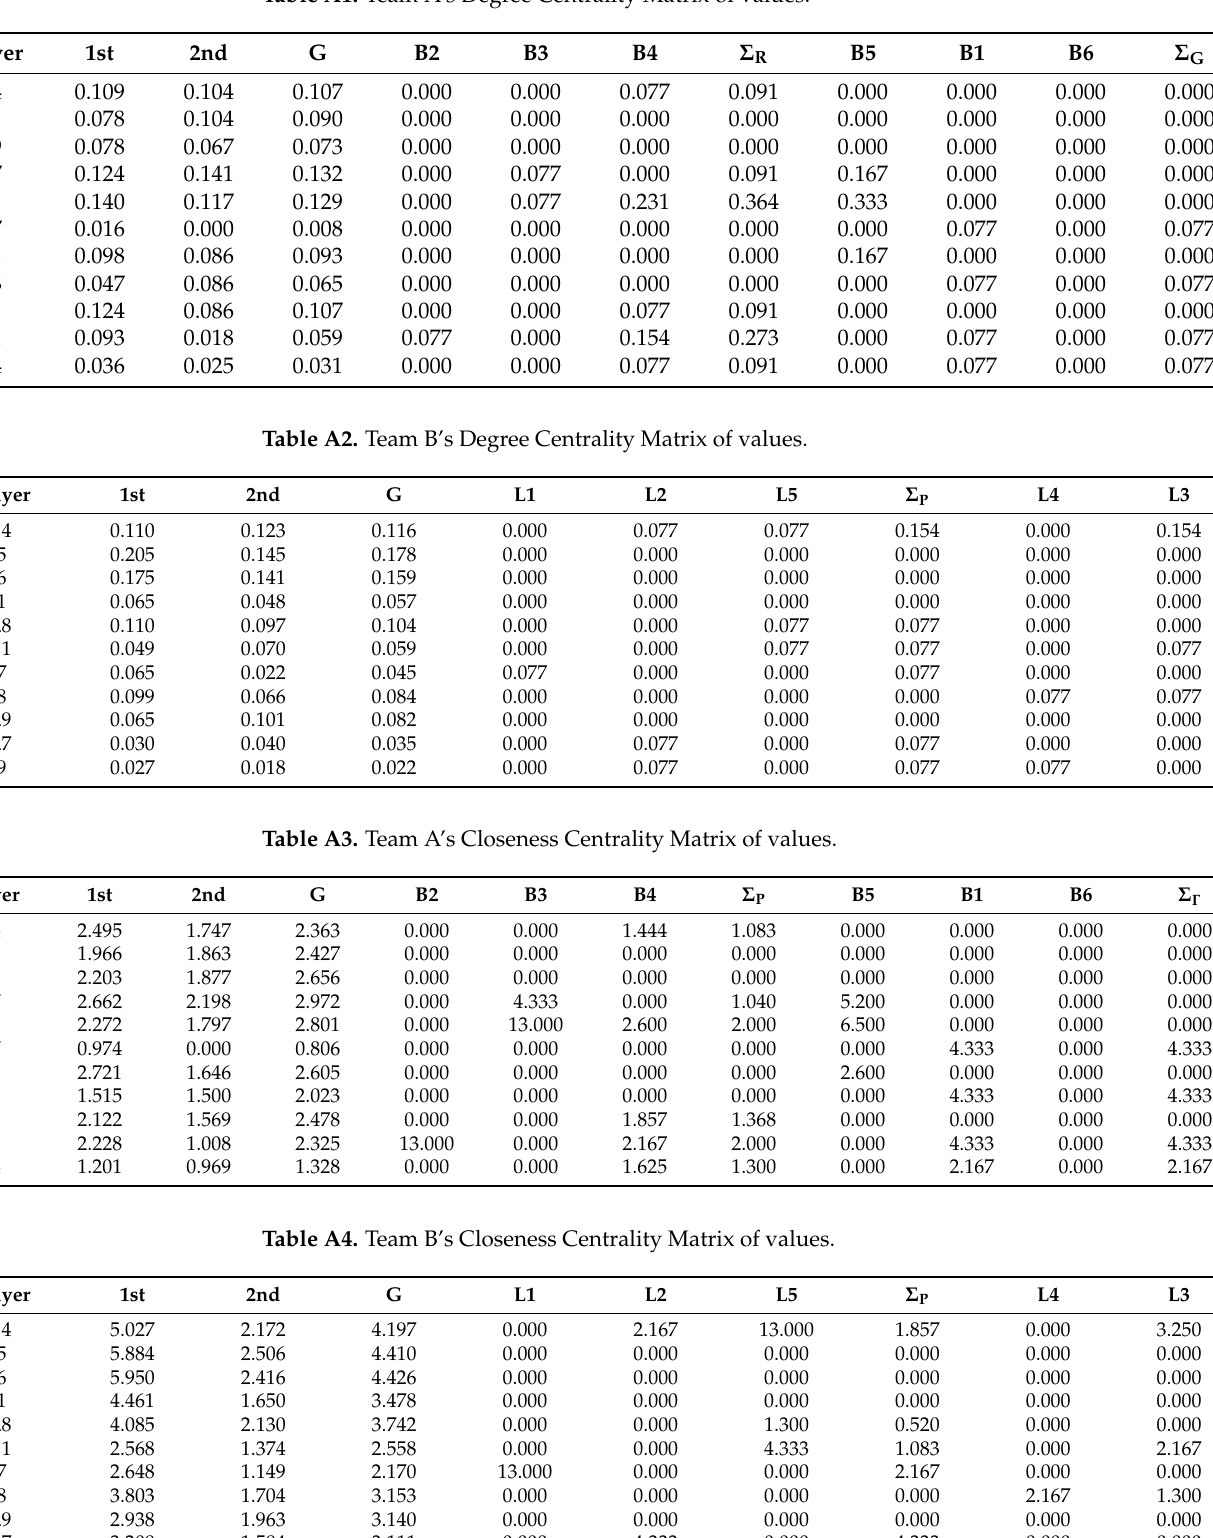
Table A1. Team A’s Degree Centrality Matrix of values.